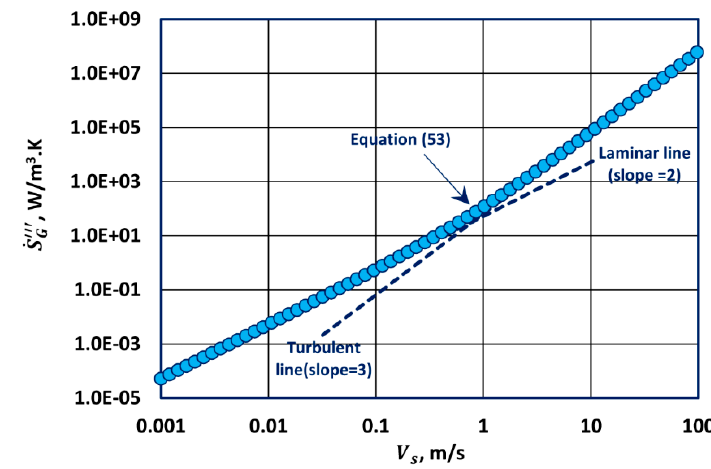
. (cid:48)(cid:48)(cid:48) S Figure 17. Prediction of Figure 17. Prediction of (cid:1845)(cid:4662) (cid:3008)(cid:4593)(cid:4593)(cid:4593) for packed beds over a broad range of fluid superficial velocity under G for packed beds over a broad range of fluid superficial velocity under the conditions: T = 298.15 K, ε = 0.40, d p = 1 mm, µ = 18.5 µ Pa · s, and ρ = 1.184 kg / m 3 . The data points are the conditions: (cid:1846) = 298.15 K, (cid:2013) = 0.40, (cid:1856) (cid:3043) = 1 mm, (cid:2020) = 18.5 µPa·s, and (cid:2025) = 1.184 kg/m 3 . The data generated using Equation (53). points are generated using Equation (53).